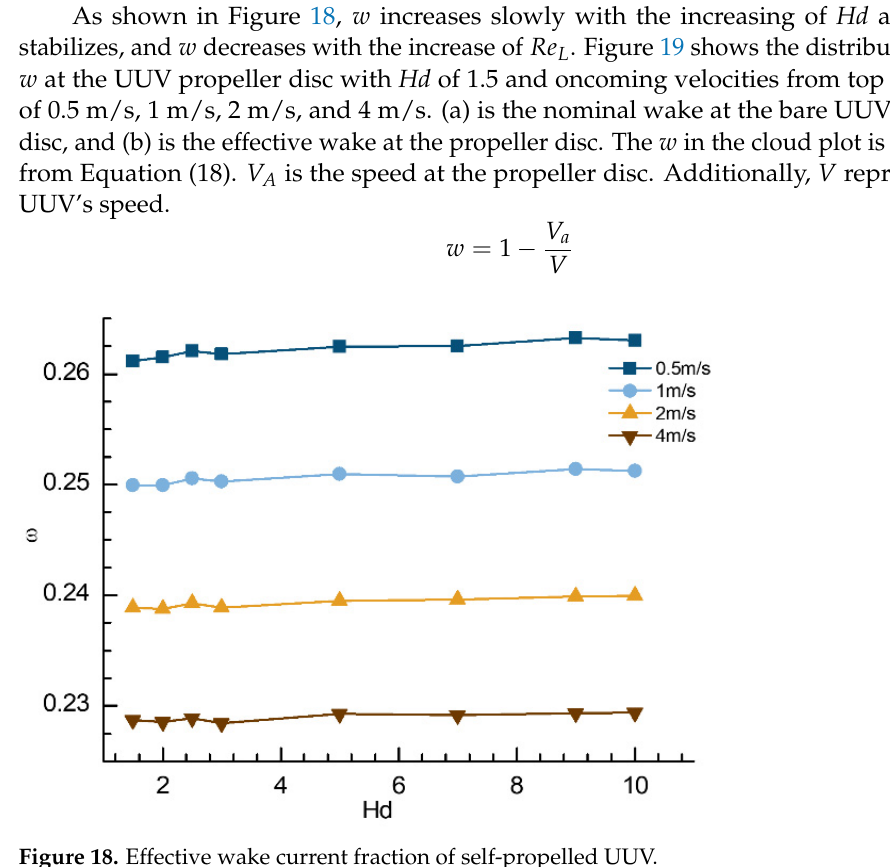
Figure 18. Effective wake current fraction of self-propelled UUV. Figure 19 shows that the effective wake is smaller than the nominal wake, and the effective wake decreases with increasing (cid:1844)(cid:1857) (cid:3013) , which is consistent with Figure 18. The shear layer formed at the trailing edge of the UUV fin plate and the turbulent boundary layer grows along the tail of the UUV together form the cross-shaped wake field at the propeller disc in Figure 19a.